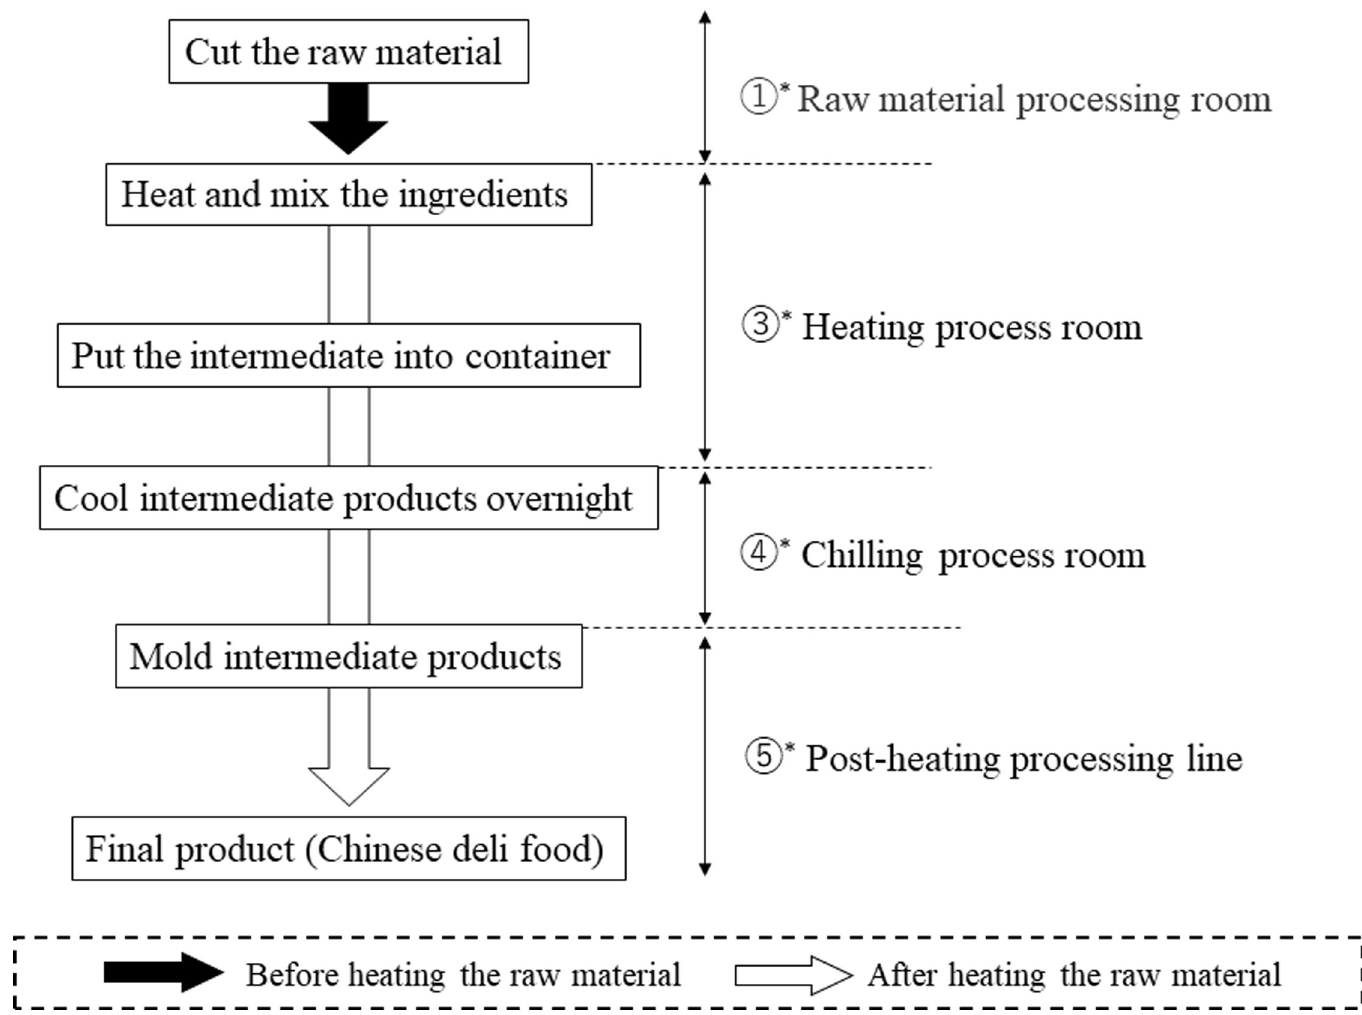
Fig 2. A schematic flow diagram of the food (Chinese deli food) processing